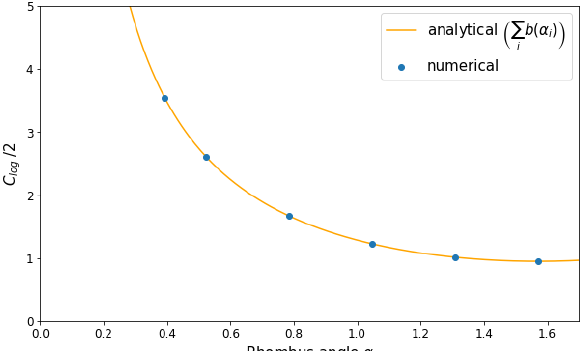
Figure 15. Numerically computed log coefficient for rhombi with side length 1 and vertex angle α .